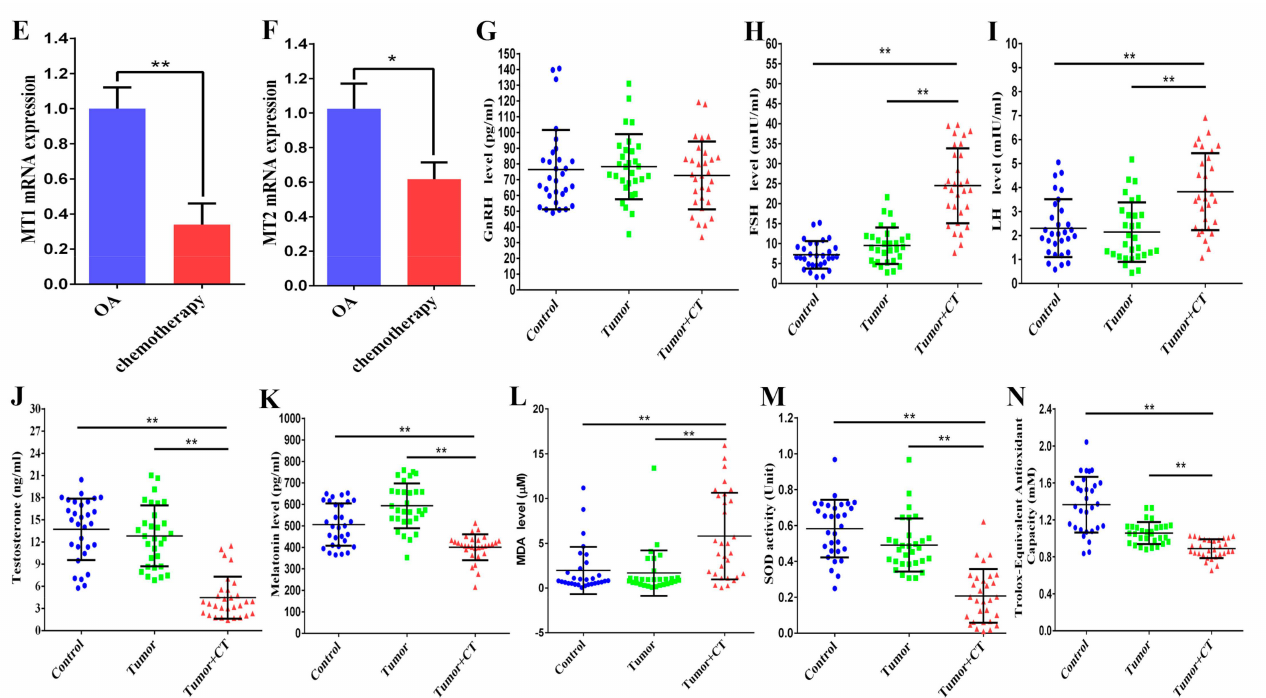
Figure 1. Effects of platinum chemotherapeutic drugs on the levels of gonadotropin, melatonin, and oxidative stress in the peripheral blood of male gastrointestinal tumor patients, and reducing the expression of MT1/MT2 in the testis. ( A ) Human testicular tissue was stained with H&E (scale bar = 50 µ m). ( B ) Images of TUNEL staining in human testicular tissue (scale bar = 50 µ m). ( C ) Representative immunofluorescent pictures of MT1 in human testicular tissue; 3 β -HSD was tagged with red fluorescence and MT1 was tagged with green fluorescence. The nucleus was labeled with DAPI (scale bar = 20 µ m). ( D ) Representative immunofluorescent pictures of MT2 in human testicular tissue; 3 β -HSD was tagged with red fluorescence and MT2 was tagged with green fluorescence. The nucleus was labeled with DAPI (scale bar = 20 µ m). ( E ) MT1 mRNA expression in human testicular tissue. ( F ) MT2 mRNA expression in human testicular tissue. ( G ) GnRH level in human serum. ( H ) FSH level in human serum. ( I ) LH level in human serum. ( J ) Testosterone level in human serum. ( K ) Melatonin level in human serum. ( L ) Content of MDA in human serum. ( M ) SOD activity in human serum. ( N ) Total antioxidant capacity in human serum. Data are presented as the mean ± SEM. N = 3 cases per group in ( A – F ). N = 30 cases per group in ( G – N ). CT, chemotherapy. * p < 0.05, ** p < 0.01 versus the control group or the tumor